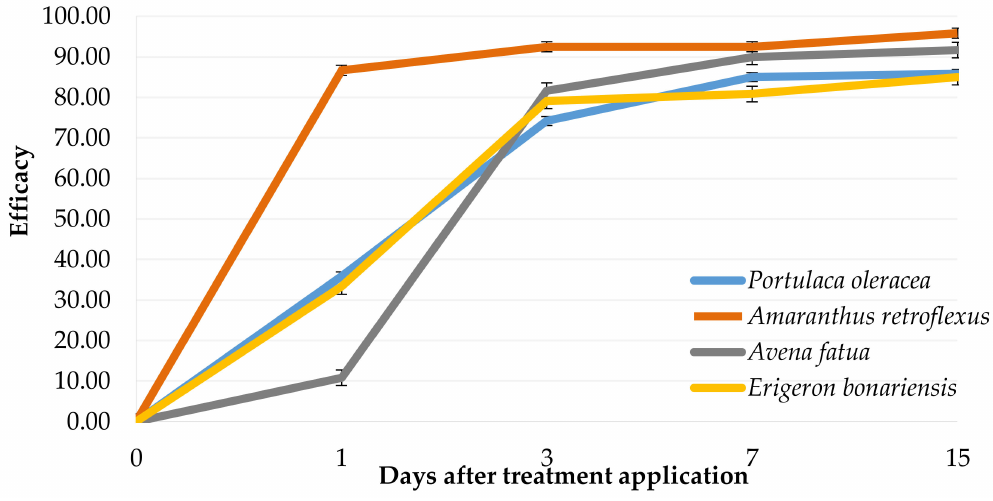
Figure 8. E ff ect of the interaction between treatment and days after treatment application in the e ffi cacy per